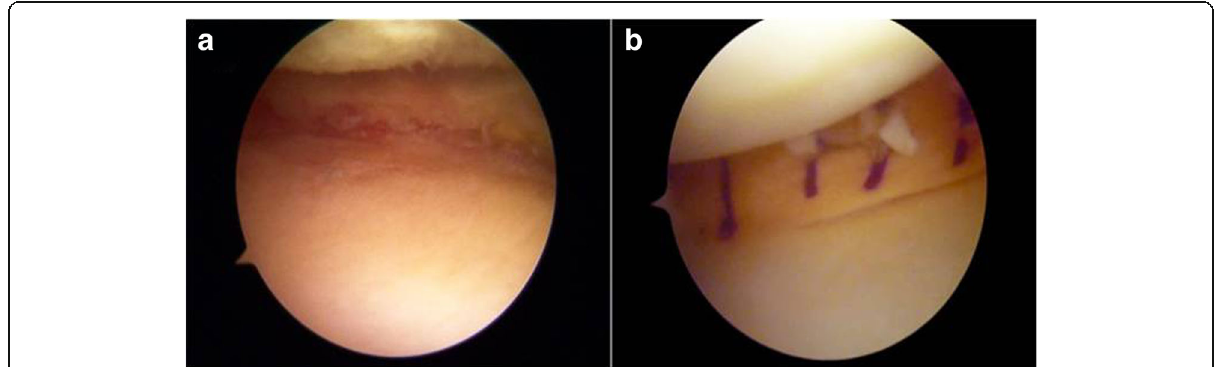
Fig. 3 Arthroscopic evaluation: ( a ) Pre-operative and ( b ) after medial MAT Patient 1